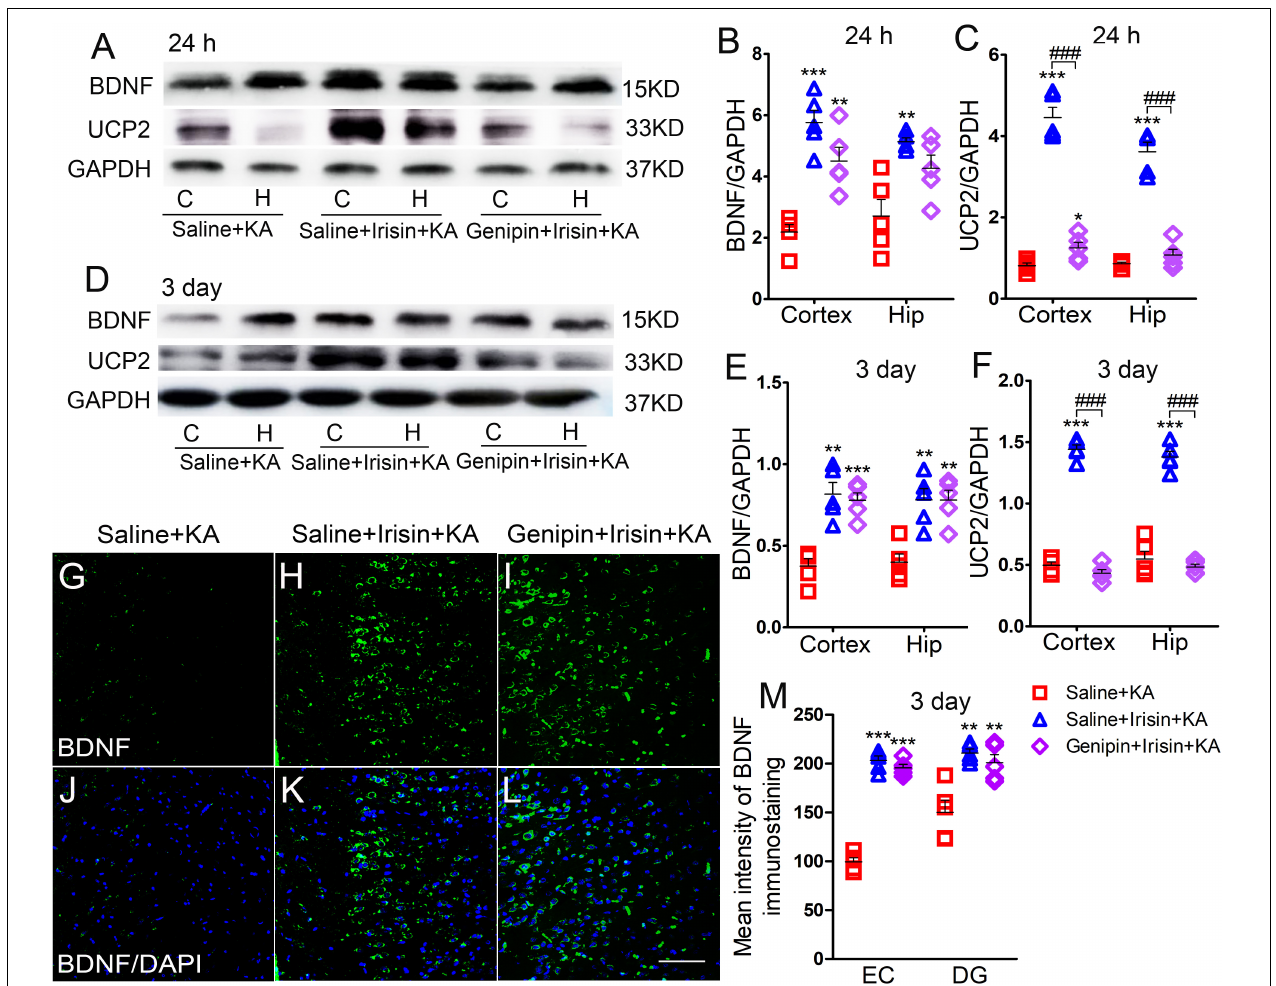
FIGURE 5 | Elevations in UCP2 levels induced by exogenous irisin treatment were reversed by genipin. (A–F) Measurements of BDNF and UCP2 expression in the cortex and hippocampus after irisin administration ( n = 5/group). (G–M) The mean fluorescence intensity of BDNF immunostaining in the left EC after genipin injection (3 days, n = 5/group). Bar = 50 µ m. * P < 0.05, ** P < 0.01, *** P < 0.001 compared with controls; ### P < 0.001 compared with each other (One-way ANOVA with Dunnett’s T3 post hoc test). C, cortex; BDNF, brain-derived neurotrophic factor; EC, entorhinal cortex; H/Hip, hippocampus; UCP2, uncoupling protein